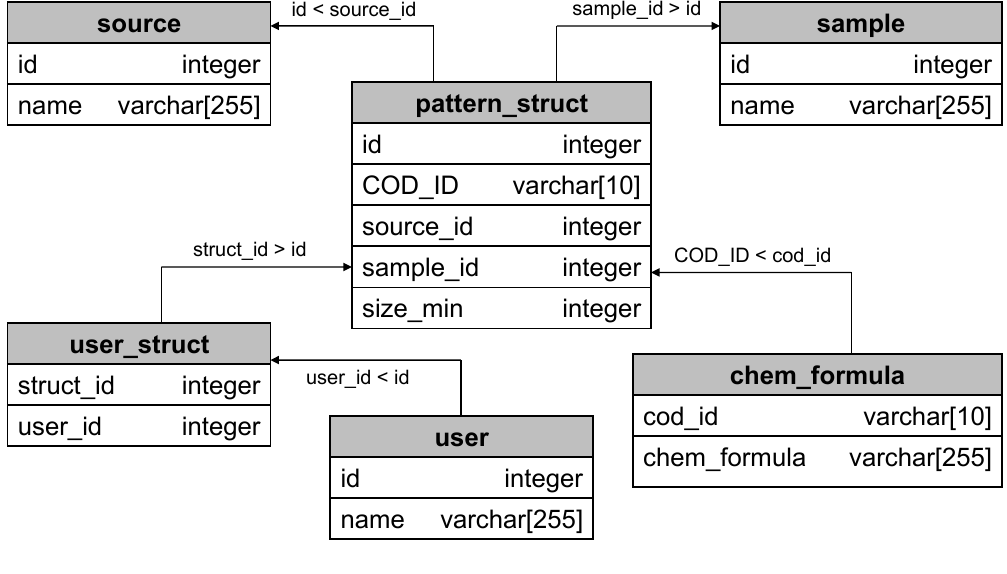
Figure 3: Schema of the database of powder diffraction patterns